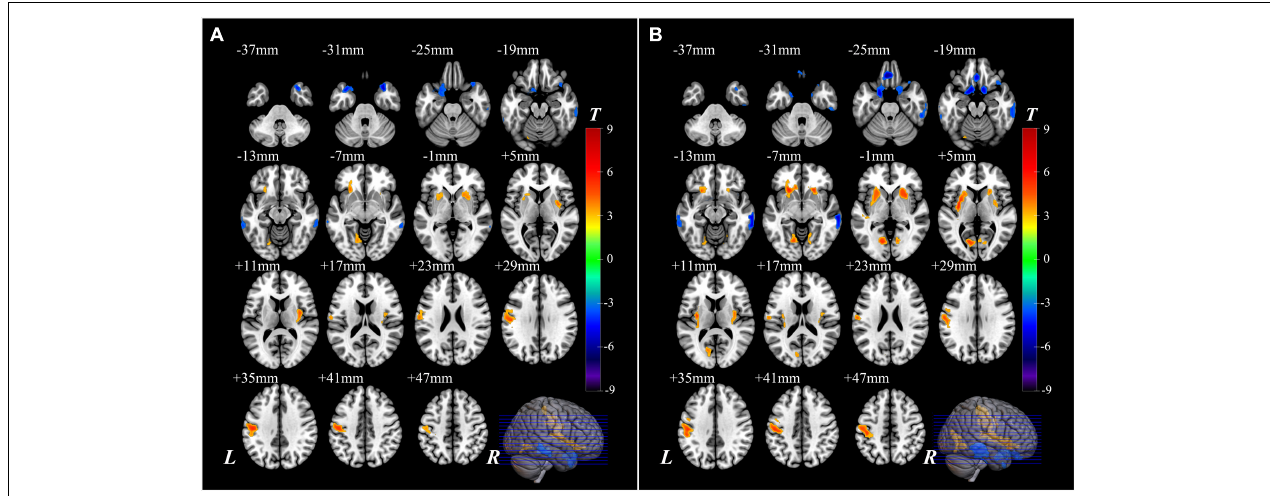
FIGURE 3 | The brain regions with significant intergroup differences of the CBF-ReHo ratio. The voxel-based analysis demonstrates the survived clusters between the HC group and PD-NC group (A) and PD-MCI group (B) . These clusters are referred to multiple comparisons correction using the FWE rate (a cluster-defining threshold of P = 0.001 and a corrected cluster significance of P < 0.05). The significantly increased ratio relative to HC in the group is shown with warm color. The significantly decreased ratio relative to HC in the group is shown with cold color. CBF, cerebral blood flow; ReHo, regional homogeneity; HC, healthy control; PD, Parkinson’s disease; NC, normal cognition; MCI, mild cognitive impairment; FWE, familywise error; R, right; L, left.